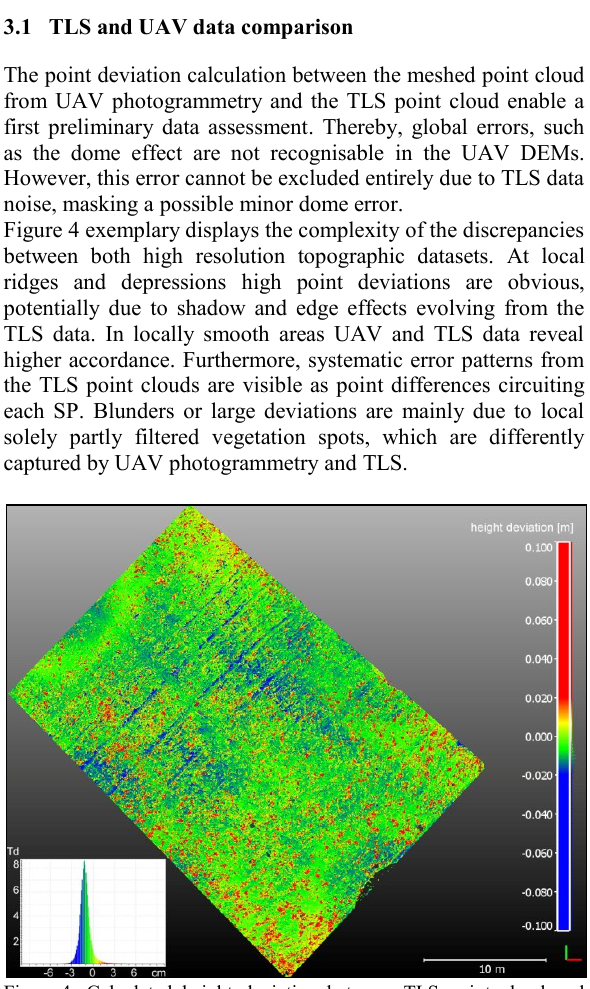
Figure 4: Calculated height deviation between TLS point cloud and UAV mesh (see also Tbl. 3). Point deviations exceeding ±10 cm are excluded from illustration due to blunders. TLS points above and below UAV mesh are red and blue, respectively. During all field campaigns, TLS point clouds are about 1